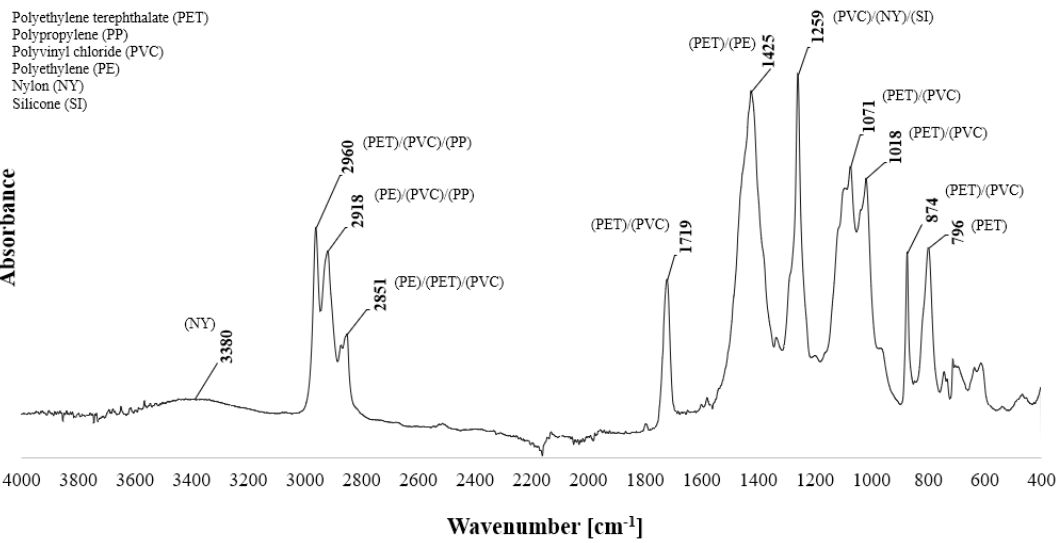
Figure 6. FTIR − ATR spectrum for recycled cable waste. Describing from the left of the spectrum, the characteristic broadly distributed peak at 3380 cm − 1 is characteristic of the stretching vibrations of the ‐ OH group. The peaks at 2918 cm − 1 and 1425 cm − 1 are characteristic of the occurrence of the asymmetric stretching